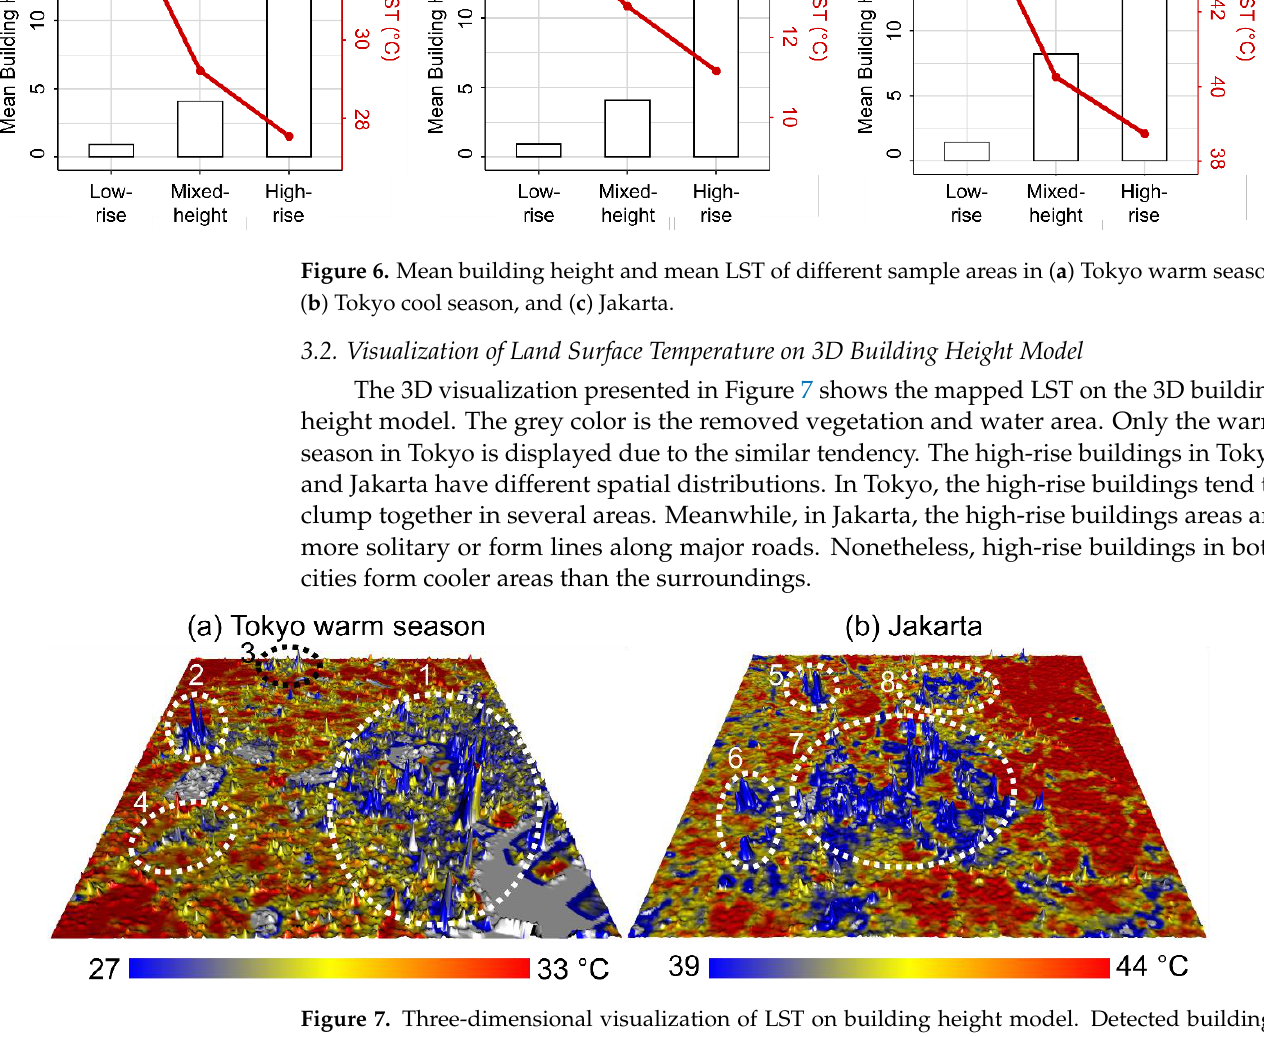
Figure 7. Three-dimensional visualization of LST on building height model. Detected buildings appear as “spikes” in the model. Higher “spikes” means higher buildings. Circle 1–8 show high-rise areas with noticeable lower LST. ( a ) Tokyo warm season, ( b ) Jakarta.